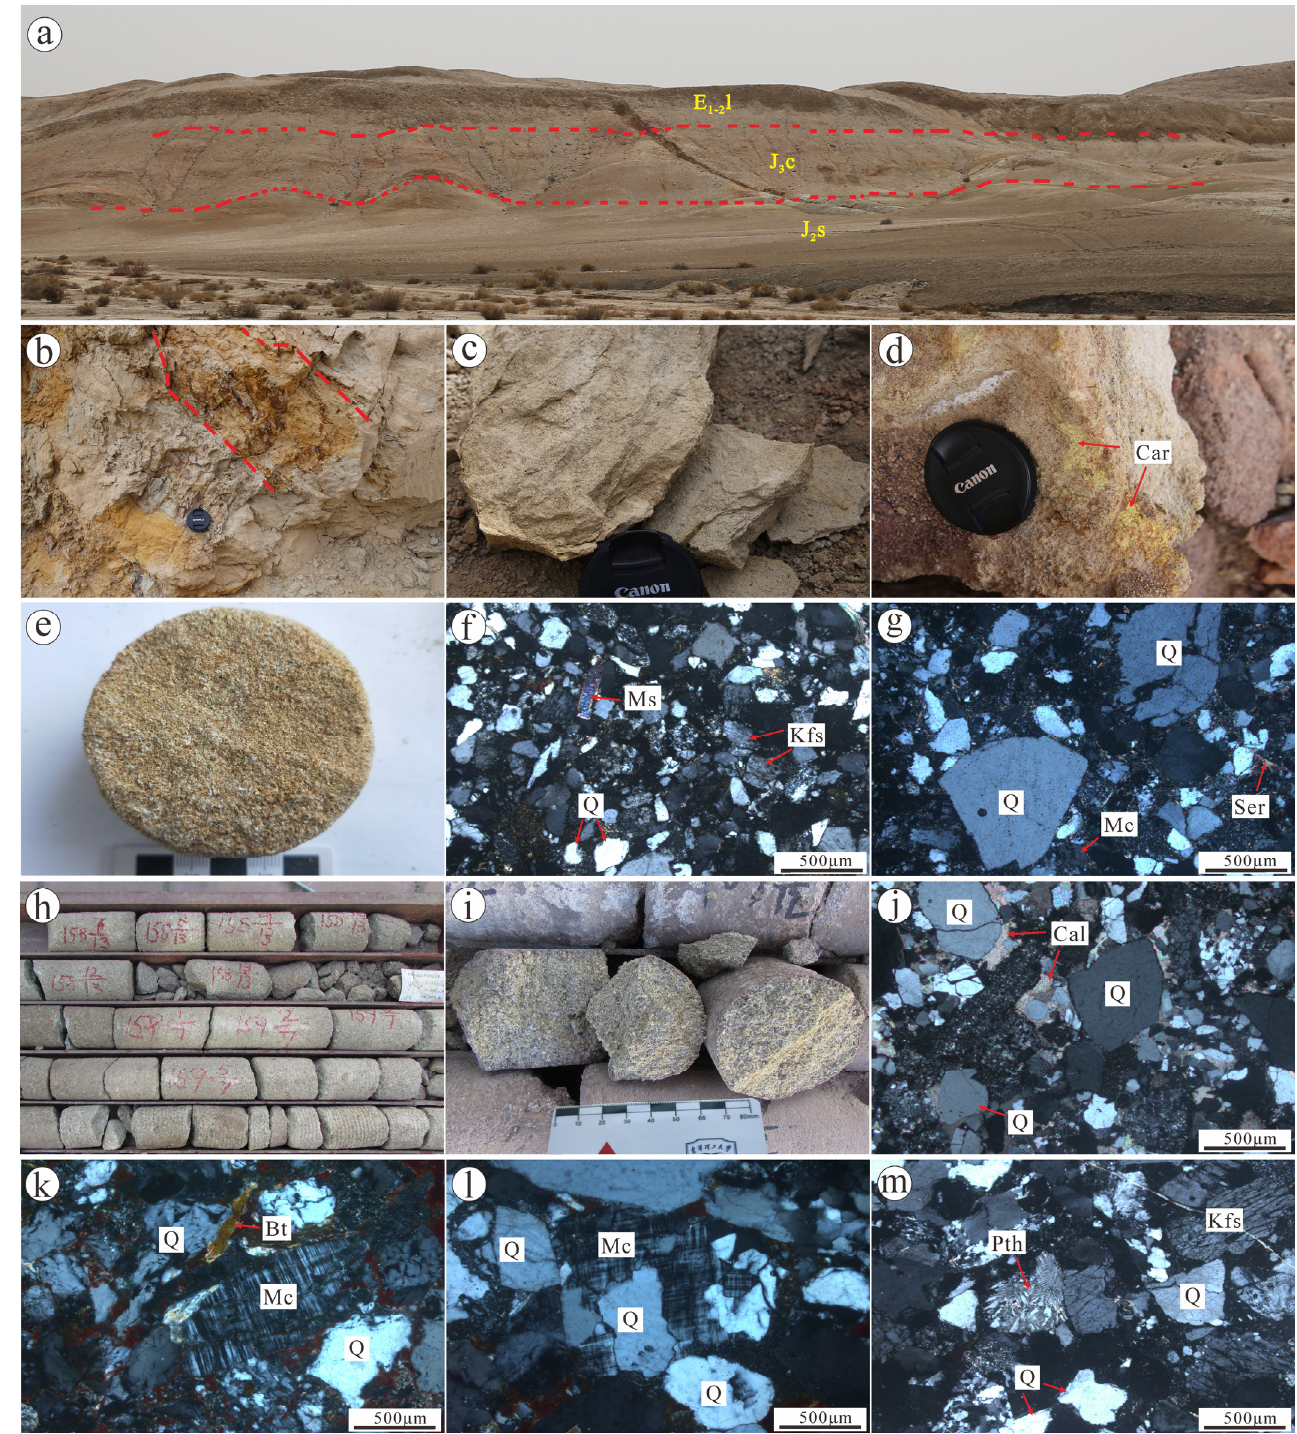
Figure 3. Characteristics of Jurassic sandstone outcrops and petrography of representative samples in Yuqia uranium ore fields. ( a ) Field outcrops of the Paleo-Eocene Lulehe Formation (E 1 – 2 l), Upper Jurassic Caishiling Formation (J 3 c), and Middle Jurassic Shimengou Formation (J 2 s); ( b ) variegated sandstones of the Upper Jurassic Caishiling Formation; ( c ) yellow-green sandstones of the Shimengou Formation of the Middle Jurassic; ( d ) secondary uranium mineral carnotites in sandstones of Shimengou Formation; ( e ) pale yellow sandstones of the Caishiling Formation exposed by drilling; ( f ) the sandstones with a sandy texture of the Caishiling Formation; ( g ) an irregularly corroded quartz edge with an obvious intracrystalline fragmentation; ( h ) the Shimengou Formation, exposed by drilling; ( i ) the Shimengou Formation ore-bearing yellow-green gritstones; ( j ) the sandstones in the sandy textures of the Shimengou Formation; ( k ) the obvious development